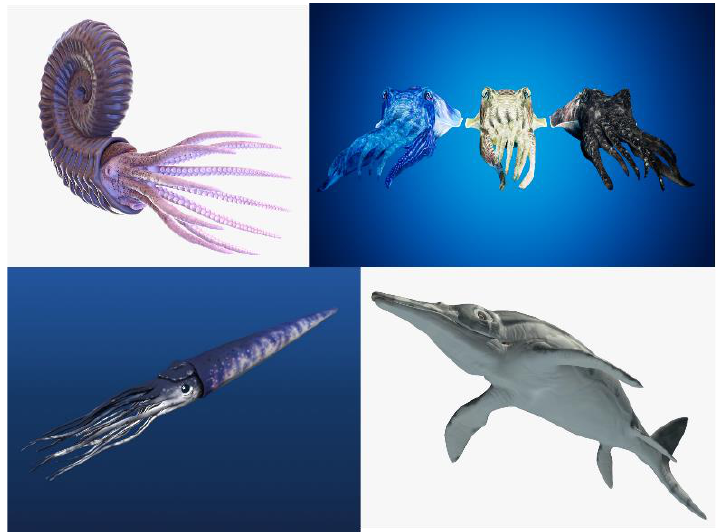
Figure 11. Some of the organisms modeled for the Jurassic marine paleoenvironment reconstruc- tion.